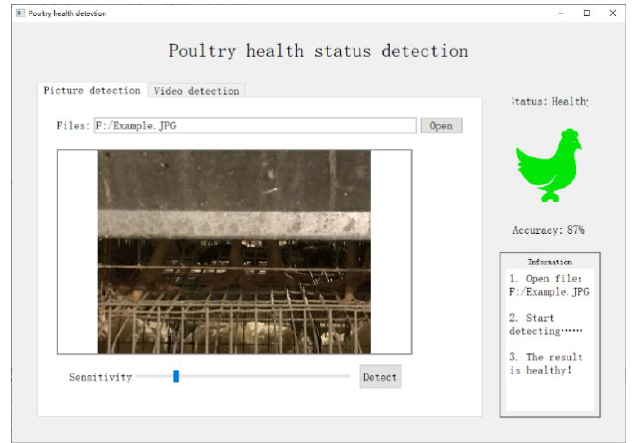
Figure 12. The software interface implemented by the disease detection function; by detecting the visual part of the poultry (the standing area below the feed trough), the current behavioral state of the poultry (standing, lying on the stomach) can be judged, and the health state of the chicken can be inferred.